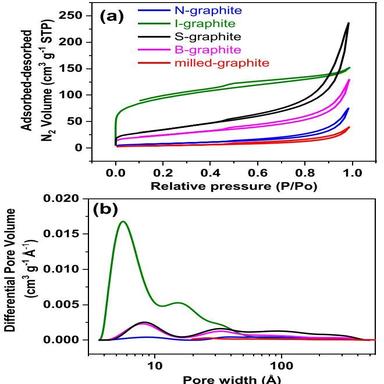
The N2 adsorption-desorption isotherms (a) and corresponding pore size distributions (PSDs) of the N-, I-, S-, B-doped graphites, and milled graphite (b).